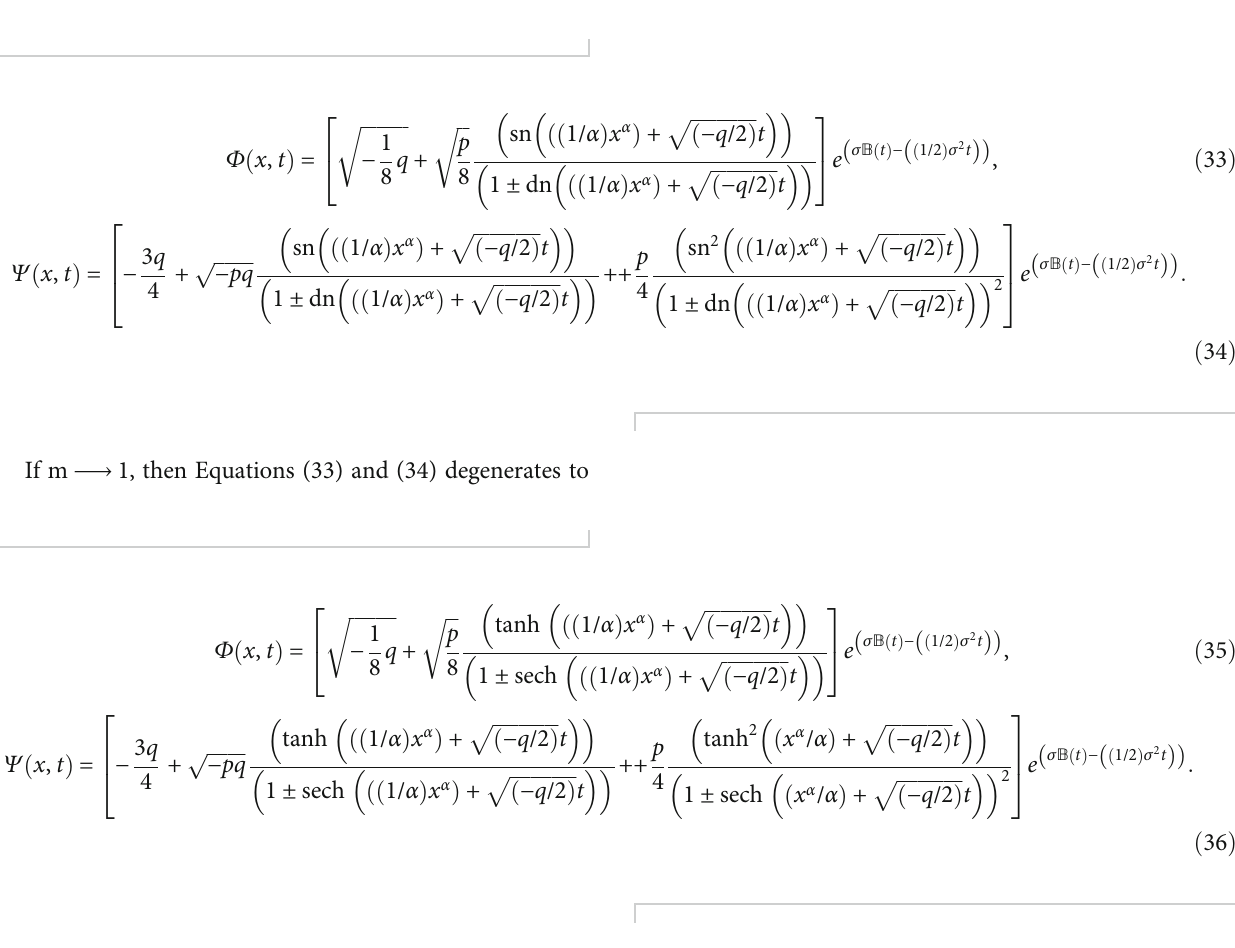
ffiffiffiffiffiffiffiffiffiffiffiffiffi − q /2 ð